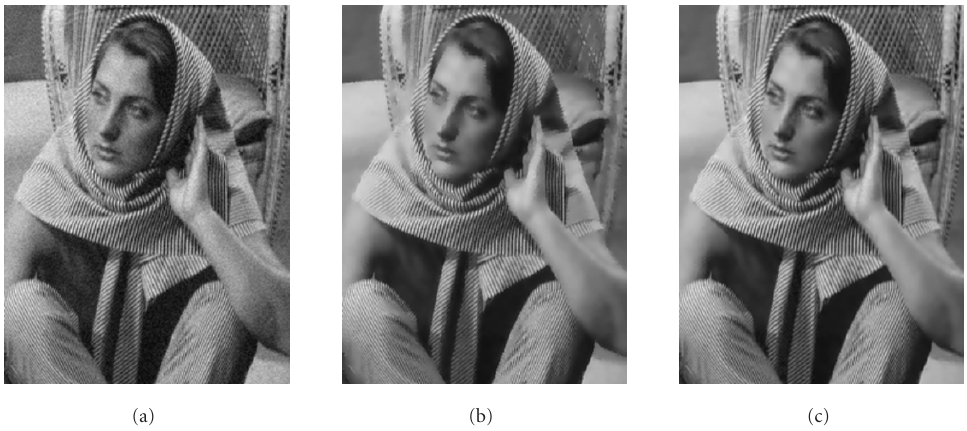
Figure 10: Visual results for processing the test image “Barbara” corrupted by (a) Gaussian noise with σ 2 n = 100 (PSNR = 28 . 12dB), (b) by the two-state hard-switching LAF (PSNR = 30 . 58dB), and (c) by the proposed three-component hard-switching LAF (PSNR = 33 .